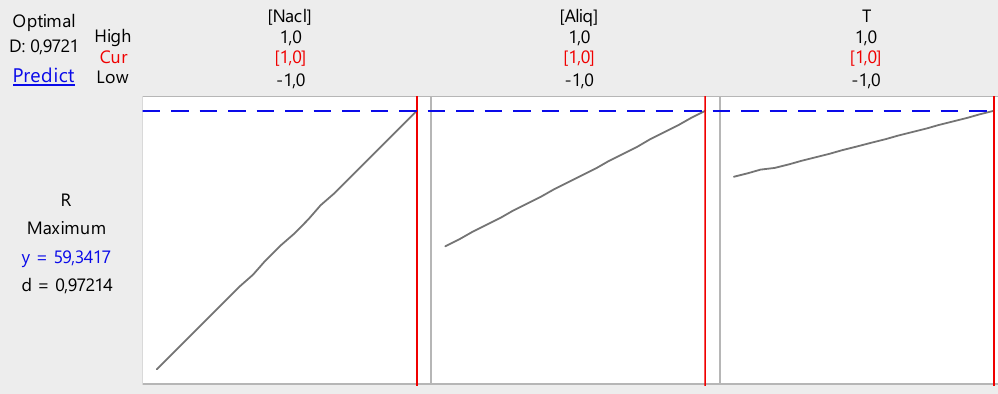
Figure 17. Optimization of back-extraction efficiency.